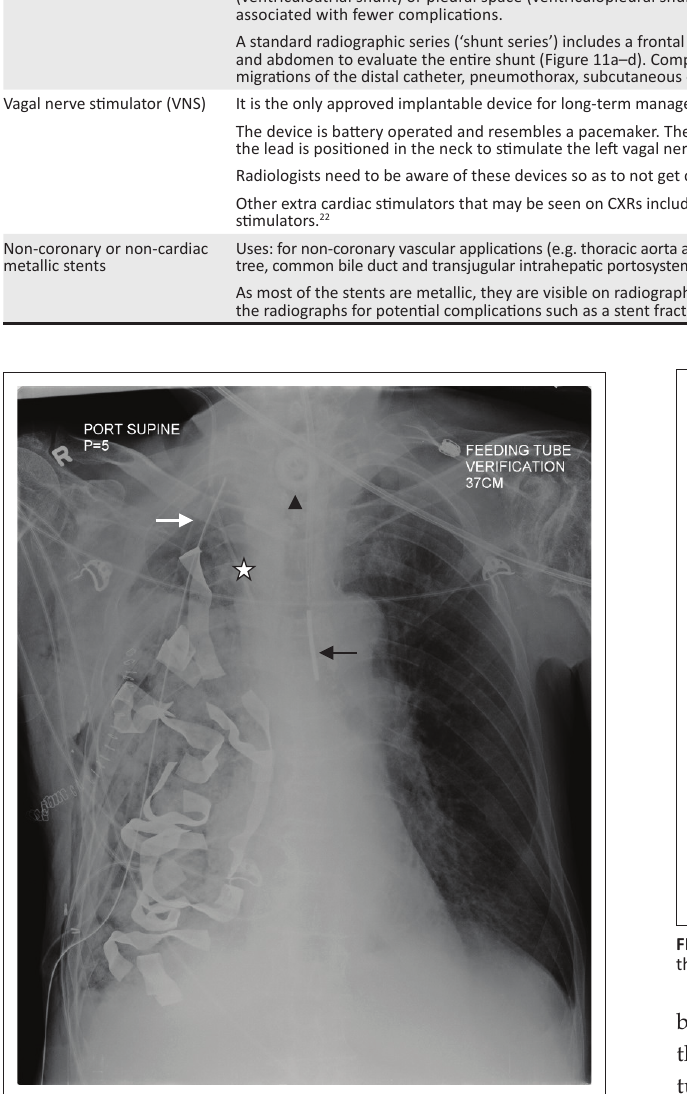
Cerebrospinal fluid (CSF) shunts